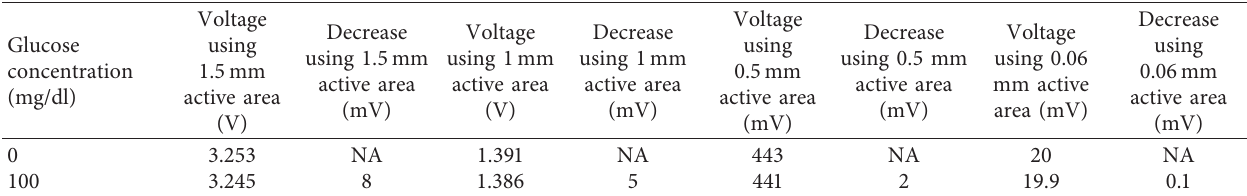
Table 5: Glucose measurement using active area of 1.5, 1, 0.5, and